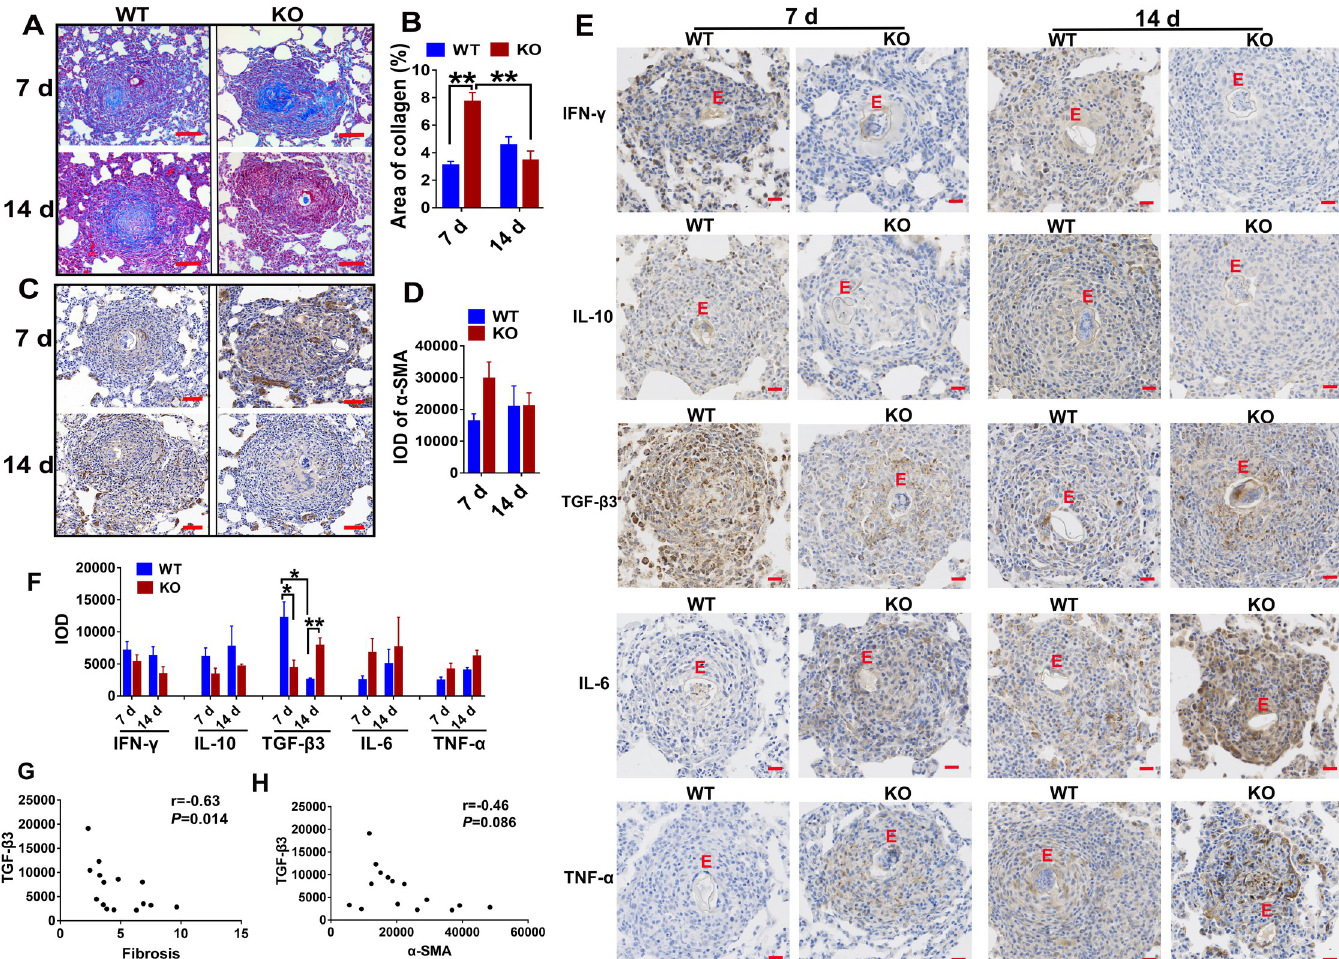
Fig 6. The progression of pulmonary granuloma-associated fibrosis is slowed in iNOS-KO rats. 15,000 eggs collected from S . japonicum infected rabbits were delivered to the lungs of WT and iNOS-KO rats via tail vein injection (i.v.), and lungs were removed for fibrosis analysis on 7 and 14 days post-challenge. (A) Representative images of pulmonary granuloma-associated fibrosis stained with Masson’s Trichrome. Blue represents collagen fibers. (B) Fibrosis was quantified from Masson’s Trichrome stained lung sections. (C) The immunohistochemistry results of α -SMA in lungs. Brown indicates the α -SMA signals. Scale bars = 50 μ m. (D) Quantitation of the expression of α -SMA. (E) Representative images of pulmonary granuloma associated cytokines expression by immunohistochemistry. Brown indicates the positive signals (Scale bars: 20 μ m). E, egg. (F) Quantitation of the expression of cytokines. The data are expressed as the mean ± SEM of 4 rats per group. Significant differences have been noted, � P < 0.05, �� P < 0.01. IOD, integrated optical density. (G) Correlation between the level of TGF- β 3 and fibrosis from Masson’s Trichrome was analyzed by the Spearman rank correlation test (r = − 0.63; P = 0.014). (H) Correlation between the level of TGF- β 3 and α -SMA (r = − 0.46; P =